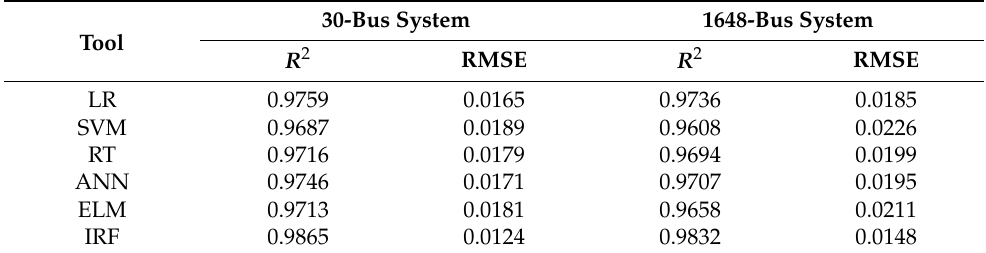
Table 2. Performance comparison between IRF and conventional tools.